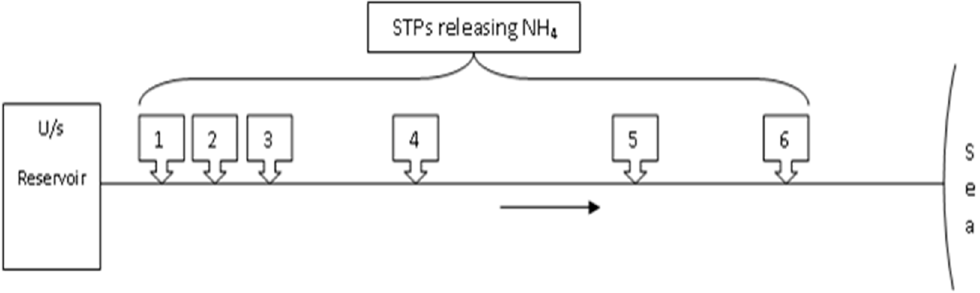
Figure 3. Schematic diagram for management models.